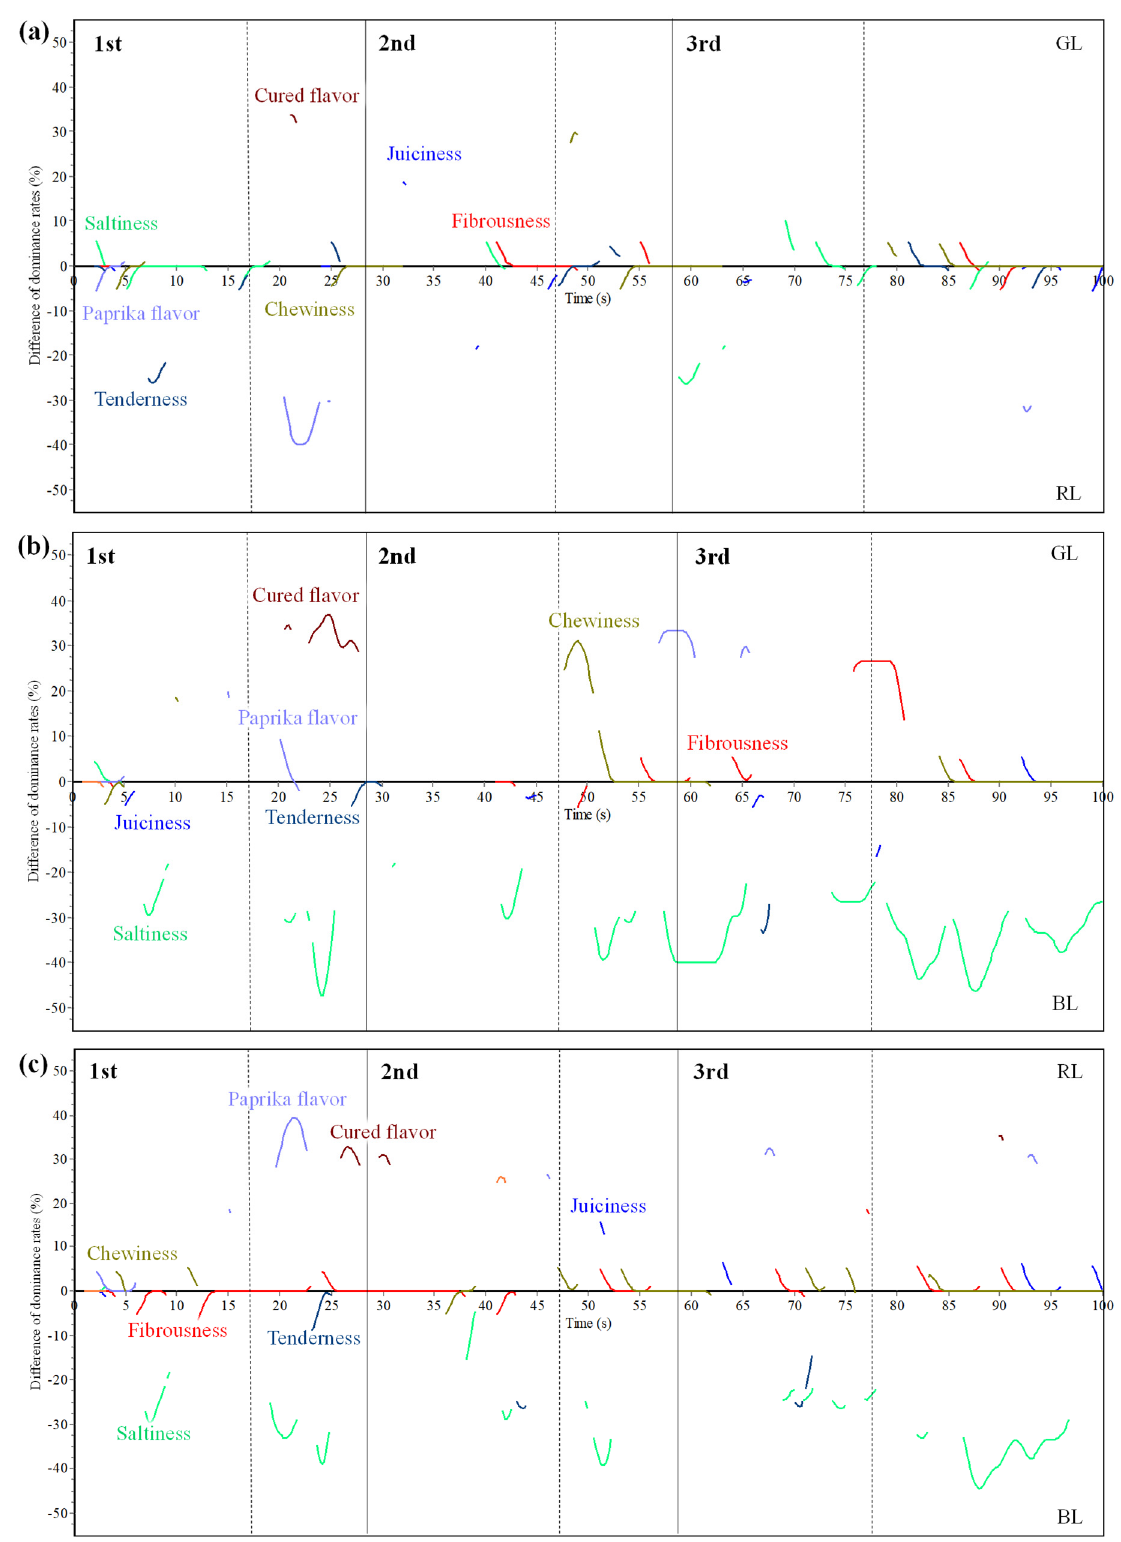
Figure 5. Difference Multiple-intake TDS curves of GL vs. RL ( a ), GL vs. BL ( b ), and RL vs. BL ( c ), filtered with a level of significance (5%) (GL = green label, Cebo de Campo Ibérico dry-cured loin; RL = red label, Bellota 50% Ibérico dry-cured loin; BL= black label, Bellota 100% dry-cured loin).